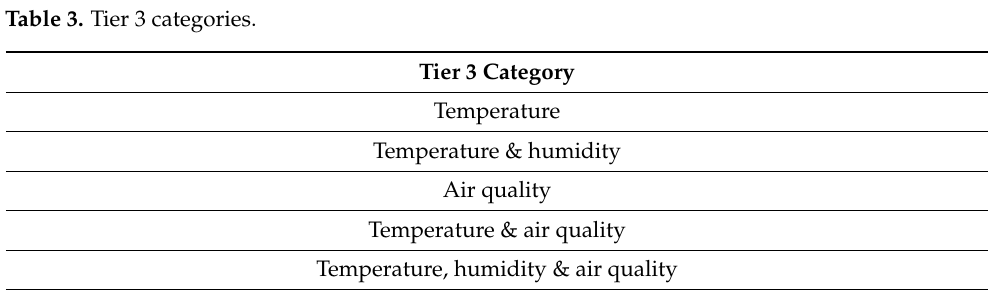
Table 2. Tier 2 categories.